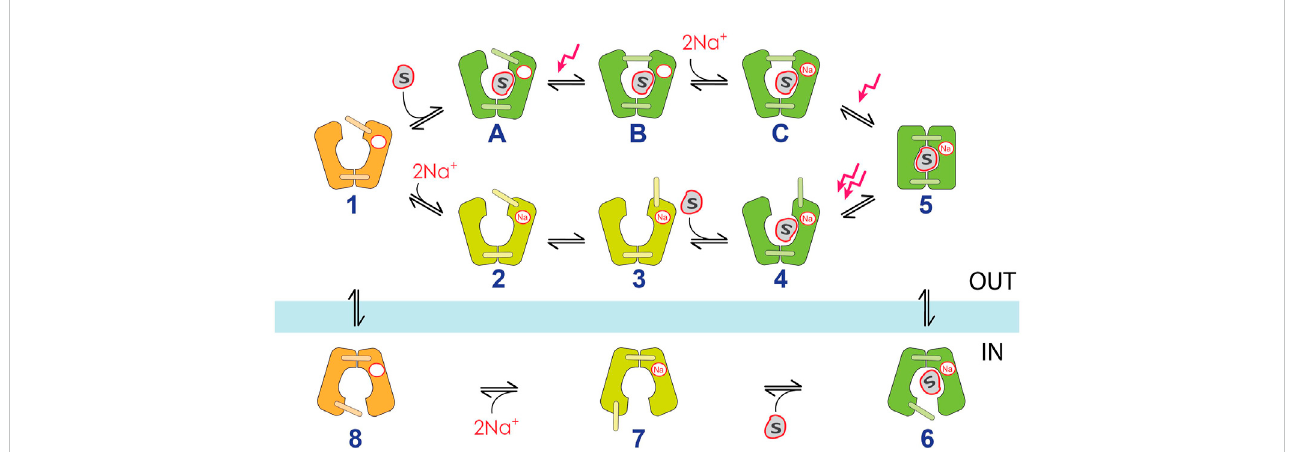
FIGURE 8 11-state kinetic model for Na + /D-glucose cotransport in SGLT1. Empty carrier conformations are shown in orange, SGLT1 conformations only bound to Na + are shown in yellow and sugar-bound conformations are highlighted green. Inward-facing conformations are shown below the blue bar, outward- facing conformations are shown above. Rate and equilibrium constants used for the simulation of the model are provided in Supplementary Table S3. Theywerederivedbasedonexperimentaldata,calculationsorliterature.Thestateswithinthemaintransportcyclearelabellednumericallyfrom1to8and includestheorderedbindingmodel when Na + binds beforethesugar (states2 – 4, “ Na + fi rst ” ).Whensugarbinds beforeNa + , analternativepathwayisfollowed, involvingthestatesA – C( “ sugar fi rst ” ).Electrogenicstepsareindicatedasredarrows:theonlyrequiredelectrogenicreactionstosimulatePSSandsteady-state currentsobservedinSSMEarerelatedtosubstratebindingtotheoutwardfacingcarrier.Withinthe “ Na + fi rst ” pathway,onlythetransitionuponsugarbindingto the Na + -bound carrier (4 → 5) is electrogenic. We therefore assume the total charge displacement for this transition being 2 elementary charges. Within the “ sugar fi rst ” pathway, the transition upon sugar binding to the empty carrier (A → B) translocates 1.2 of an elementary charge, while the transition upon Na + binding to thesugar-bound carrier(C → 5) translocates 0.8 of an elementary charge as found previously (Bazzone et al., 2022a). The total transporter current is calculated by I = 1.2*([A]*kAB — [B]*kBA) + 0.8*([C]*kC5 — [5]*k5C) + 2.0*([4]*k45 — [5]*k54). Please note that the different conformational states within the substrate-bound carrier are illustrations that not necessarily represent the occurring conformational changes. For visualization purposes, we pictured the conformational statesusing different positions oftheextracellular gate(statesB and3) and a major conformational transitionto a fully occluded conformation (state 5). Electrogenic conformational transitions do represent local conformational transitions, which may rather follow an induced fi t mechanism upon substrate binding, rearranging the local structure of the binding pockets, as proposed previously for H + -coupled sugar transporters (Bazzone et al.,